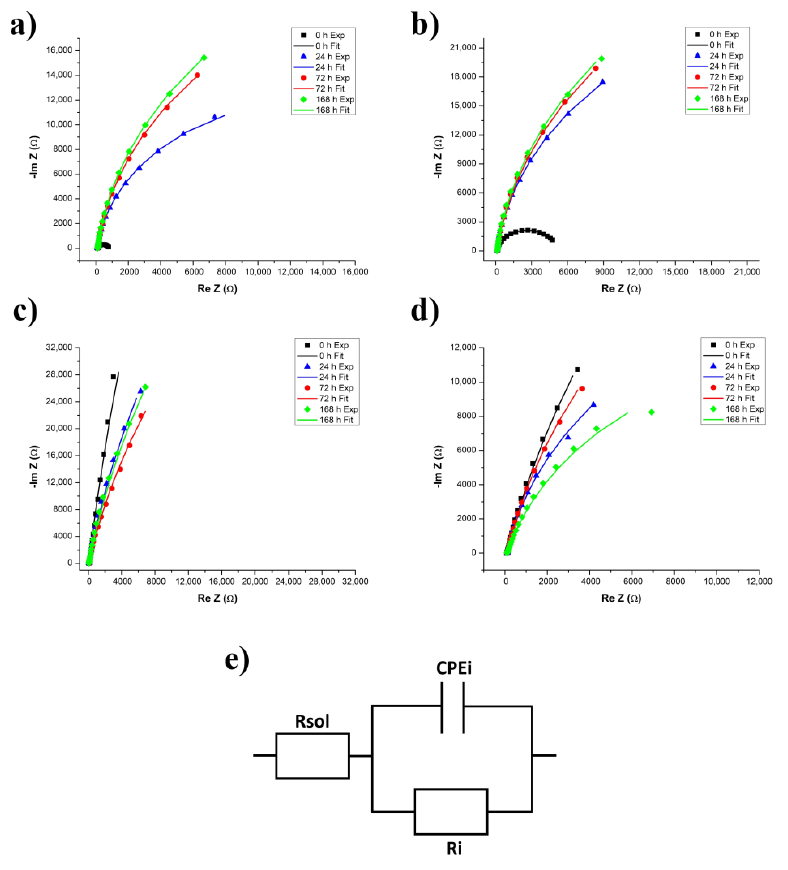
Figure 10. The electrochemical impedance spectroscopy measurements in artificial saliva at various numbers of immersion times and the fitted data for ( a ) Sample 1, ( b ) Sample 2, ( c ) Sample 3, ( d ) Sample 4, and ( e ) the EIS-proposed circuit used to fit these experiments. The symbols represent the experimental data (Exp), while the continuous lines represent the fitted (Fit) results.